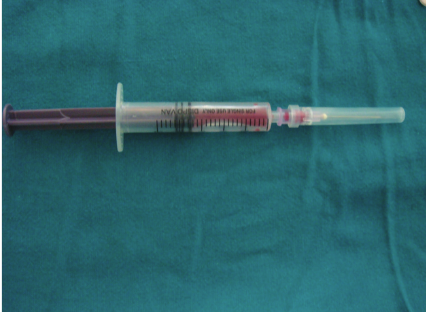
Figure 2: Aspiration consists of blood.